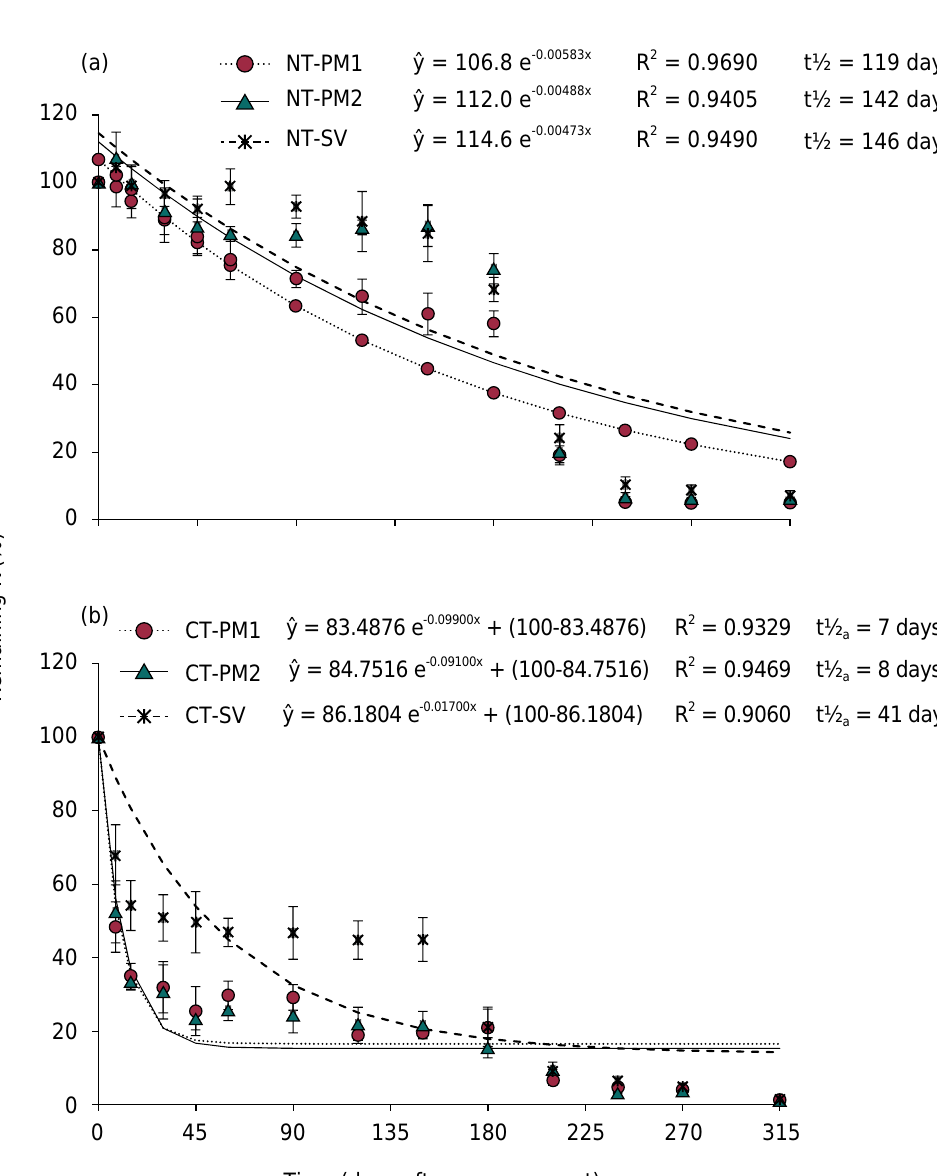
Figure 8. Remaining potassium of aboveground phytomass after management of three mixtures of cover crops in mango interrows in Petrolina, Pernambuco, Brazil. (PM1 = 75 % leguminous species + 25 % grass and oilseed species; PM2 = 25 % leguminous species + 75 % grass and oilseed species; and SV = spontaneous vegetation) under two soil tillage systems (NT = no tillage (a); CT = conventional tillage (b); t½ = half-life time; t½ a = half-life time of more easily decomposable compartment. Bars represent the standard error of the